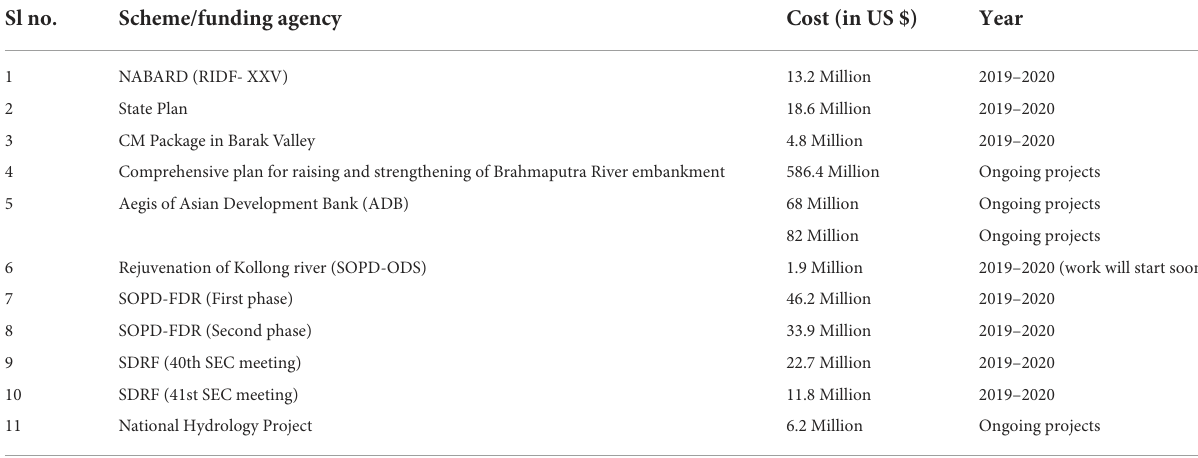
TABLE 1 Flood management and embankment schemes taken up by Water Resource Department in 2019–2020 * . Sl